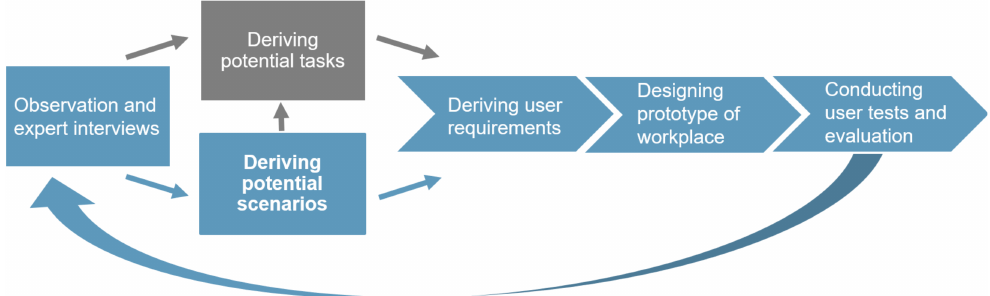
Figure 2. Empirical application of the user-centered design process by the authors. Observations and expert interviews serve as a basis both for deriving potential tasks and, which is the focus of this paper, on deriving potential scenarios. Both help derive user requirements that in turn inform the design of a workplace prototype, which will be validated by conducting user tests and evaluations. These results feed back to investigations of the context of use that has been initially